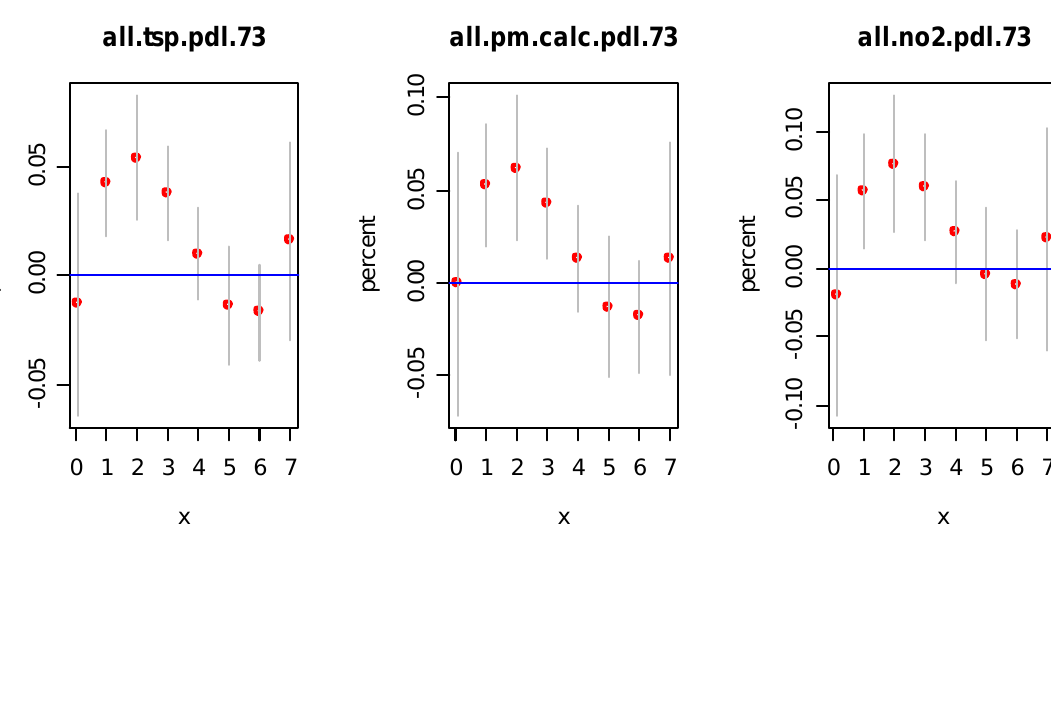
Figure S1. Temporal patterns of air pollution effects in Graz. The title of each graph indicates: cause of death, pollutant (pm.calc. indicating that PM TSP), pdl (indicating that those are PDL models), and 73/143 (7 and 14 days lags, 3rd degree polynomial). X axis: day, Y axis: change (in%) of daily number of deaths associated with 10 mg/m³